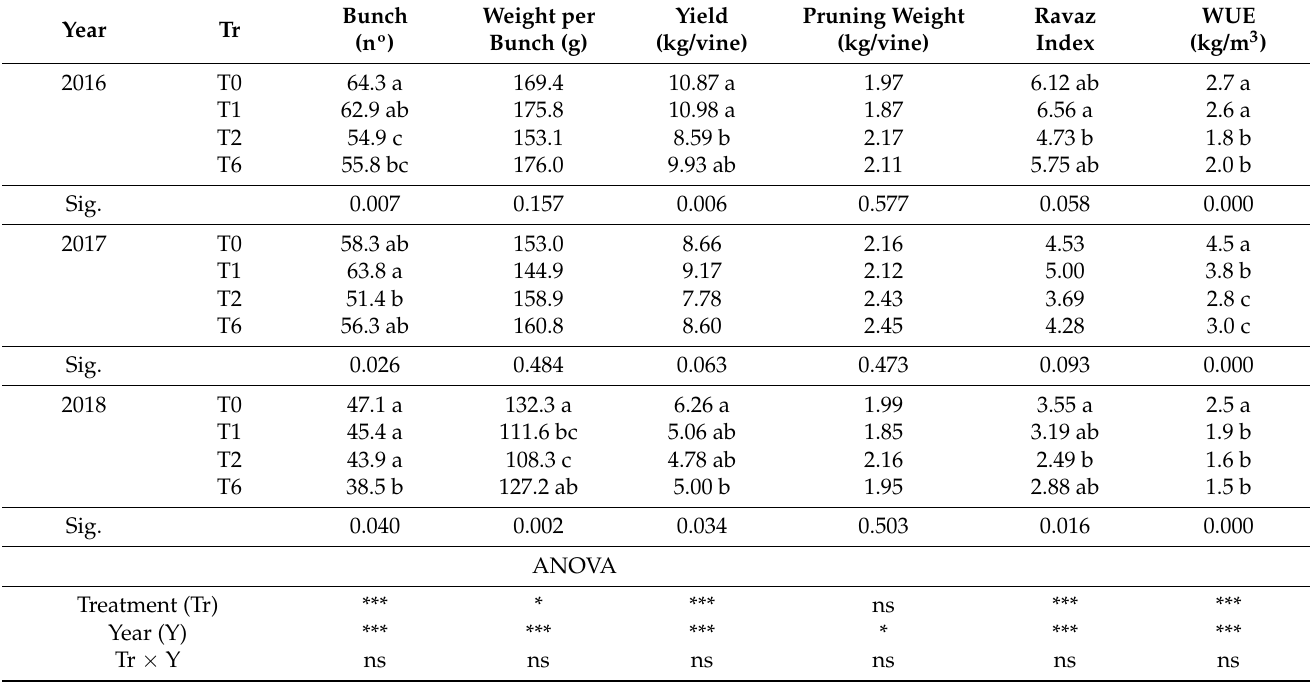
Table 2. Production parameters, pruning weight, and Ravaz index over three